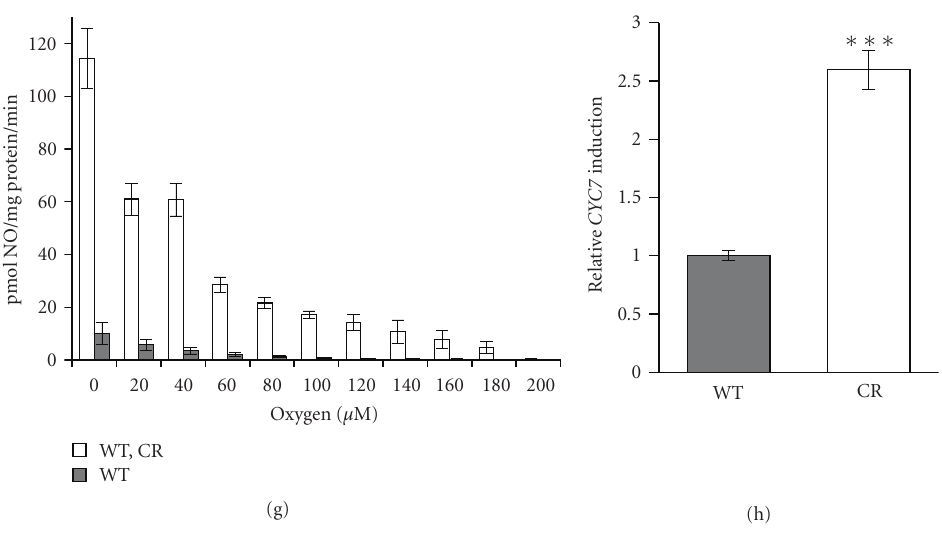
Figure 4: Mitochondrial respiration and NO production play important roles in CR-induced lifespan. (a) All potential CR mimic mutants show increased oxygen consumption. (b) CR-induced CLS is prevented in the cyt1 Δ mutant. Numbers on x - axes denote the number of days after entering stationary phase (nonmitotic state). (c) CR mimic mutants-induced RLS is prevented in the cyt1 Δ mutant. (d) Increases in NO by CR or CR mimic mutants are largely abolished in the cyt1 Δ mutant. (e) CR-induced NO production is not inhibited by L- NAME, an NOS inhibitor. (f) Involvement of the respiratory chain in cellular NO production. Cells (160mg) were suspended in 2 mL of PBS and prebubbled for 5min with N 2 to create anoxic conditions. After 5min of prebubbling, NaNO 2 was added to a final concentration of 1mM, and NO production was measured with an NO polarographic electrode. Insert: NO production rates for BY4742 ρ + (black), BY4742 ρ 0 (white), and cyt1 Δ (grey) for cells that were grown to log phase in 2% glucose (normal) or 0.5% glucose (CR). (g) E ff ects of oxygen concentrations on mitochondrial NO production. Isolated mitochondria from cells grown under normal and CR conditions were assayed for NO production in assay medium as described in the Materials and Methods Section. (h) CR increases CYC7 gene expression using a β -galactosidase reporter-based promoter activity assay. Original values: 39 ± 2 nmoles ONPG converted/min/mg protein for WT; 105 ± 4nmoles ONPG converted/min/mg protein for CR. WT: BY4742 and BY4742 ( ρ + ) wild-type control; ρ 0 : cells lacking mitochondrial DNA; CR: 0.5% glucose. One representative set of experiment is shown. Error bars denote standard deviations. P values are calculated using Student’s t -test ( ∗ P < . 05; ∗∗ P < . 01; ∗∗∗ P < .